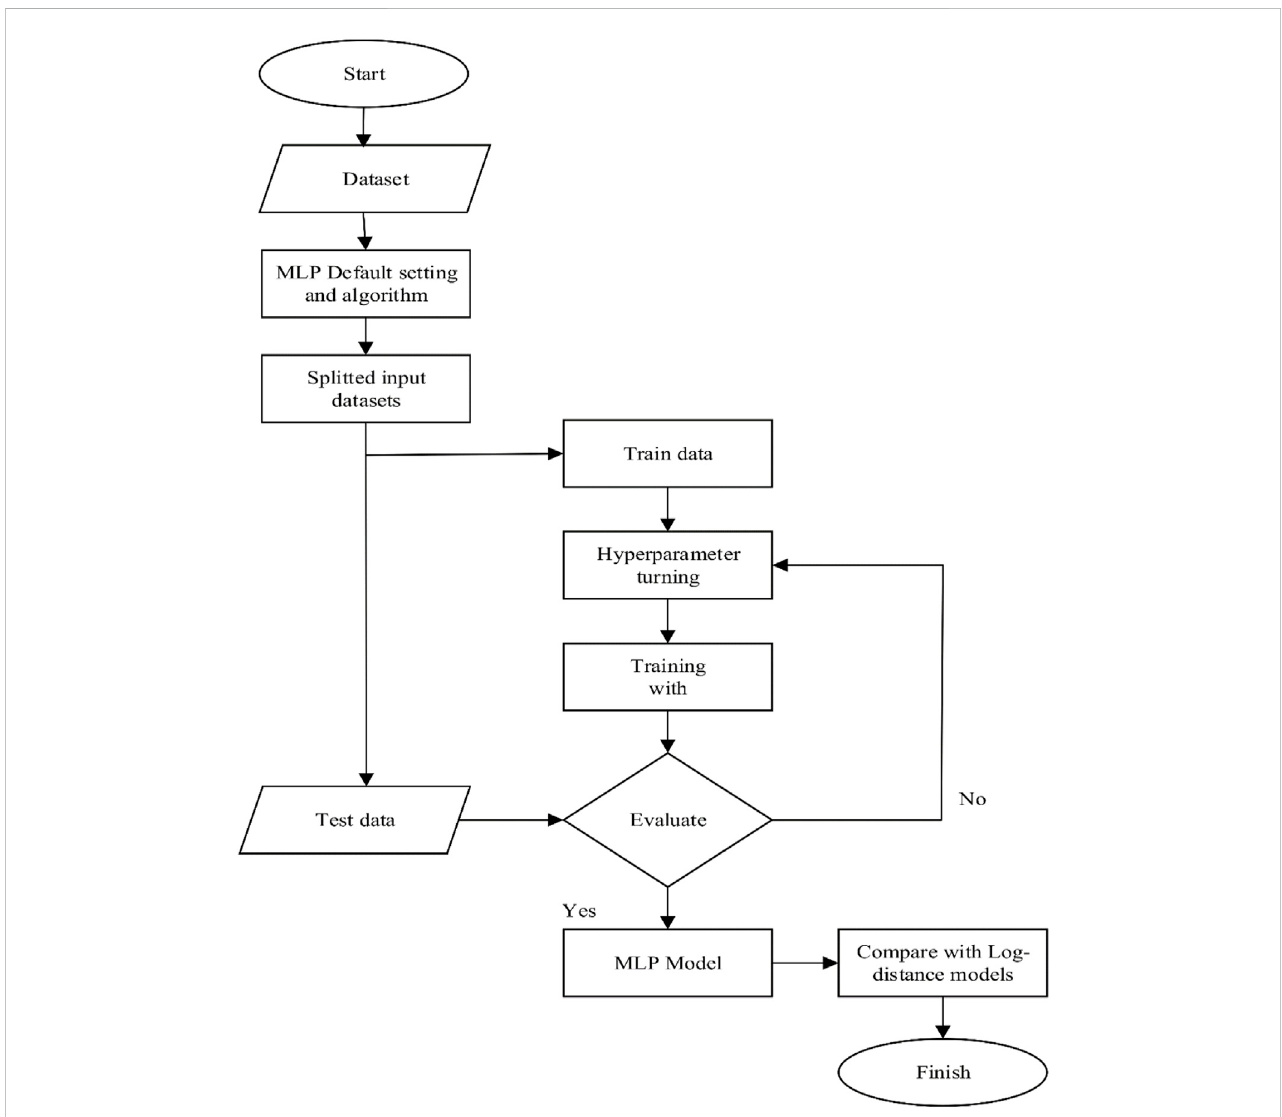
FIGURE 4 MLP model implementation process (Isabona et al., 2022).